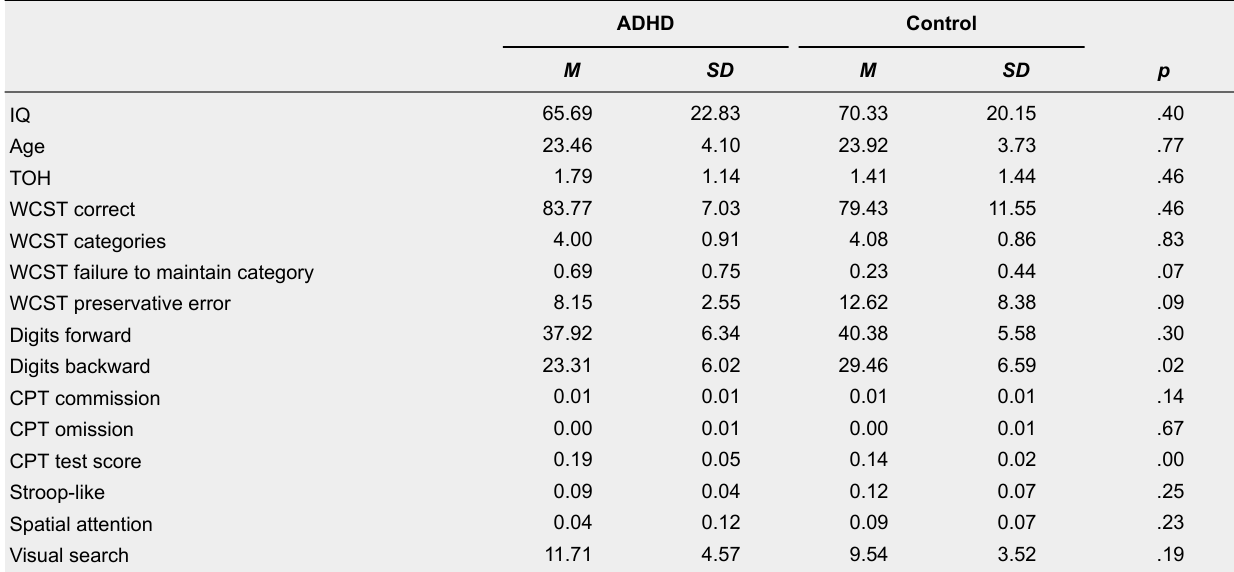
Standardized IQ, Executive Functions, Working Memory, and Attention Scores for Participants in the ADHD and Control Groups ADHD